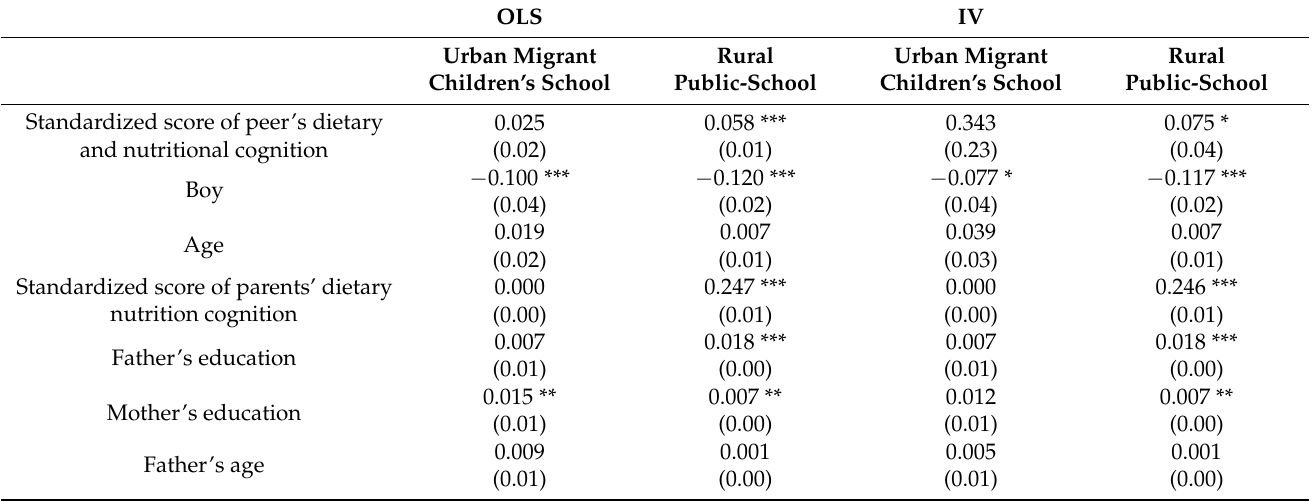
Table 8. Peer effect on the cognition of diet and nutrition for students in urban migrant children’s school or rural